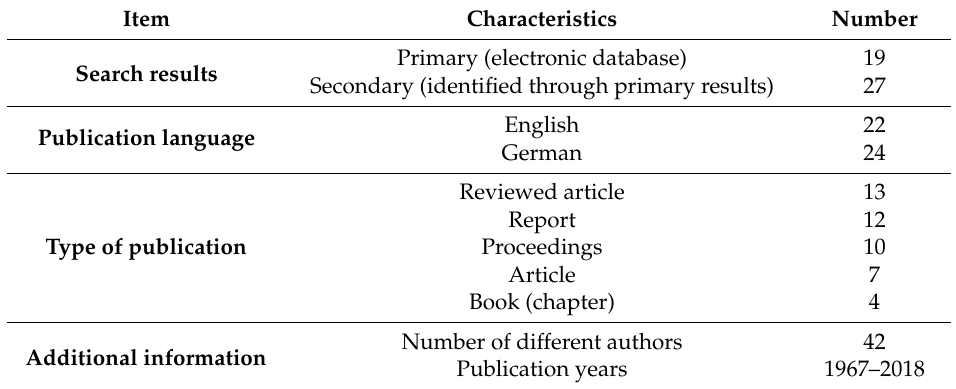
Table 1. Descriptive information about the 46 full-text articles assessed for eligibility for this study.